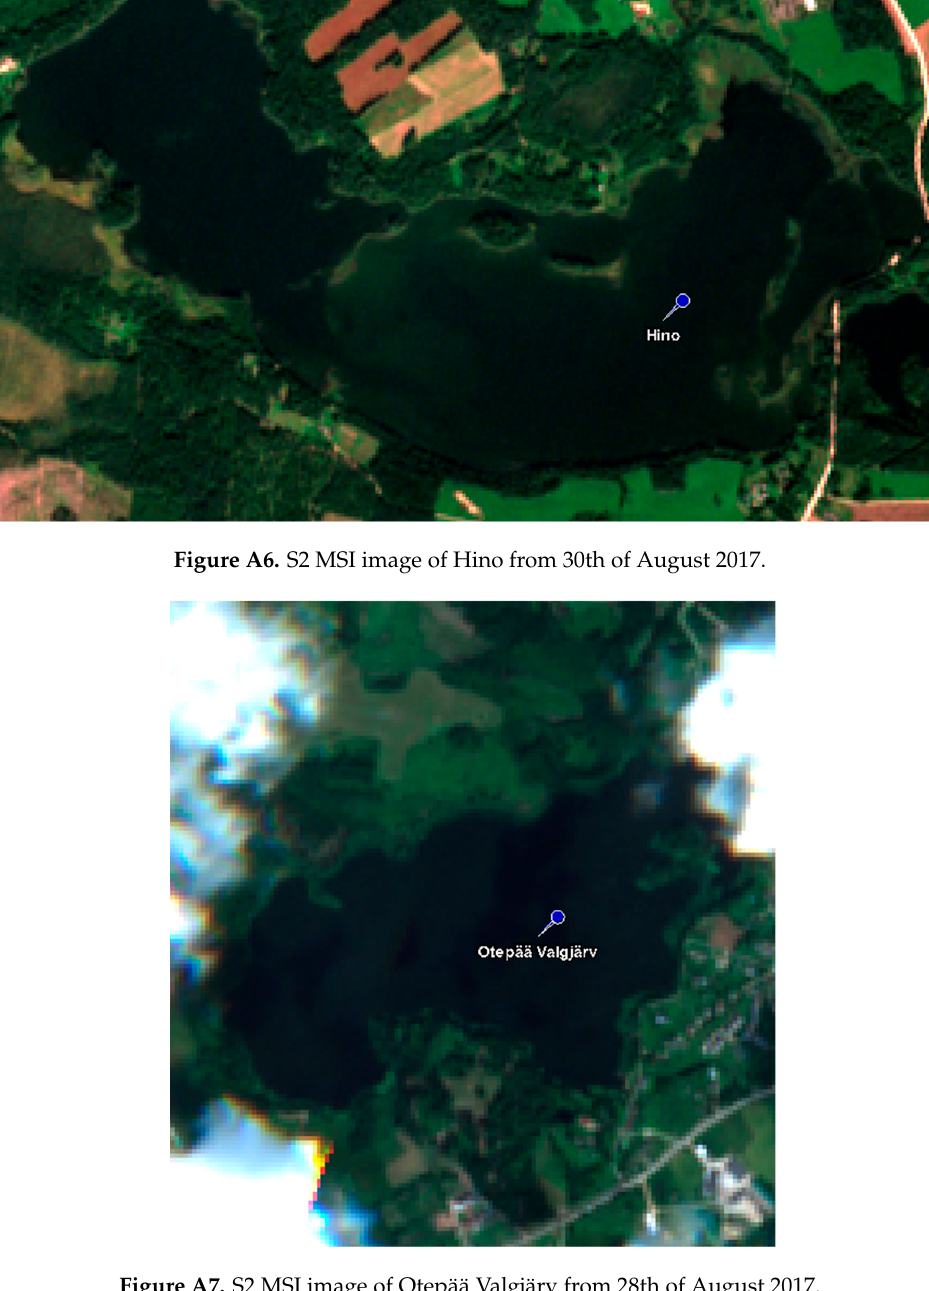
Figure A7. S2 MSI image of Otepää Valgjärv from 28th of August 2017.